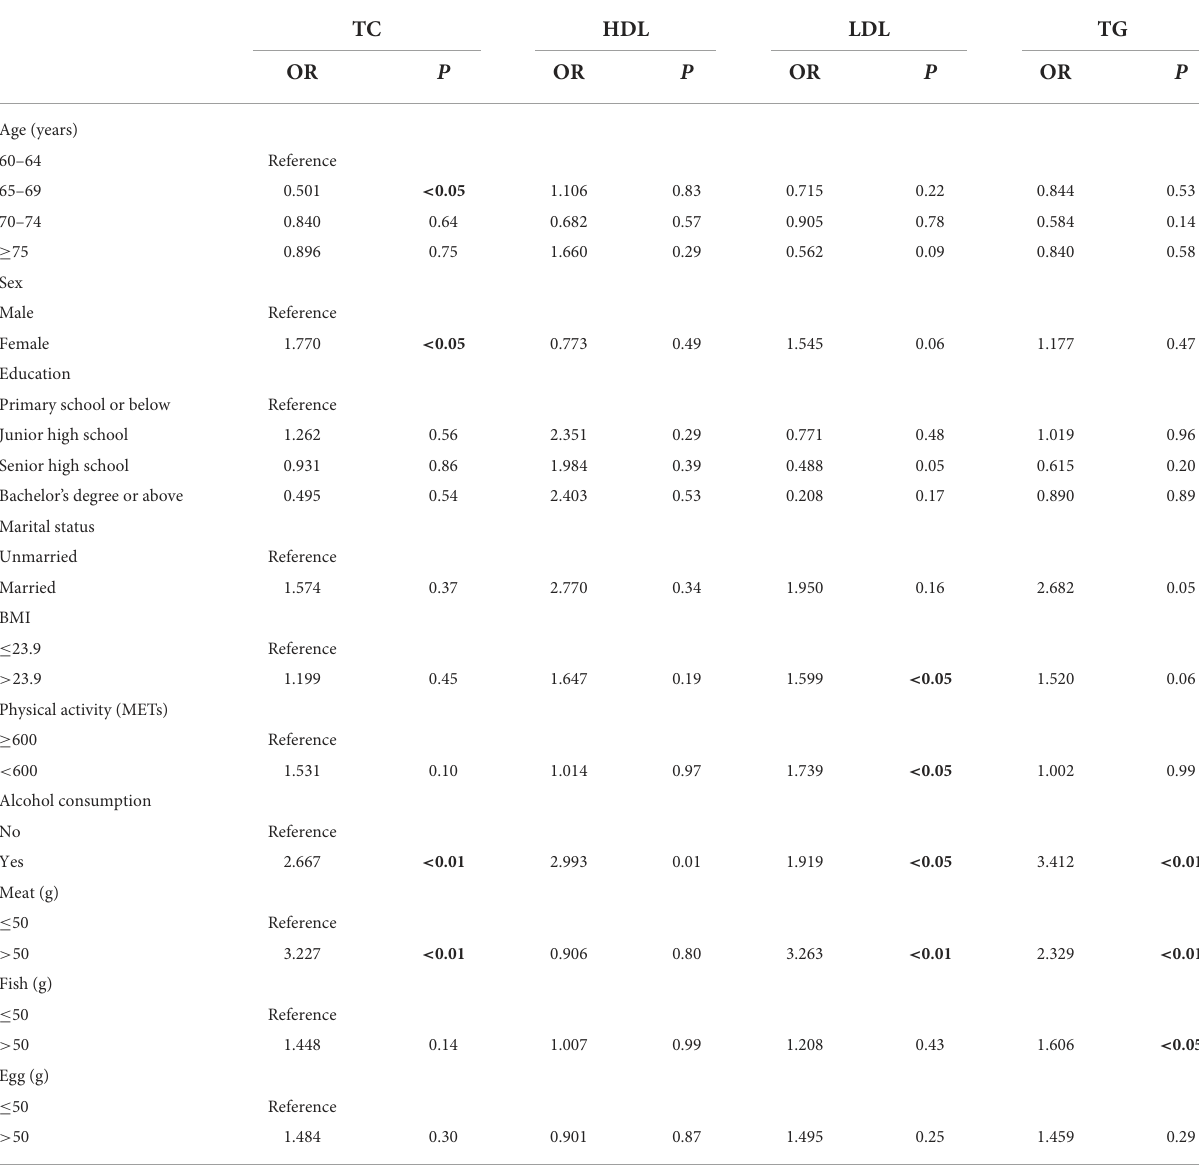
TABLE 3 Multiple logistic regression analysis of 4 blood lipid indicators.